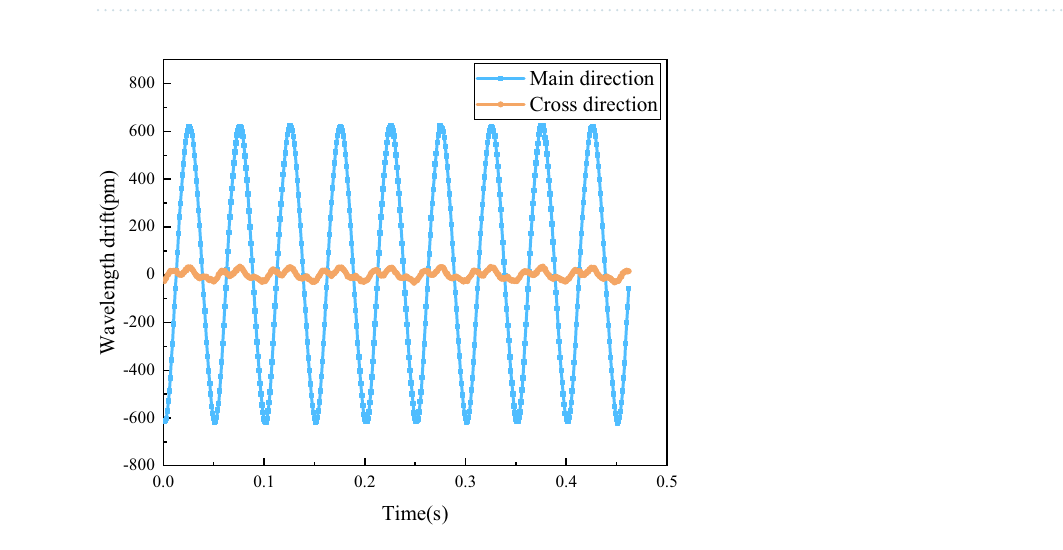
Figure 15. Transverse interference immunity test.